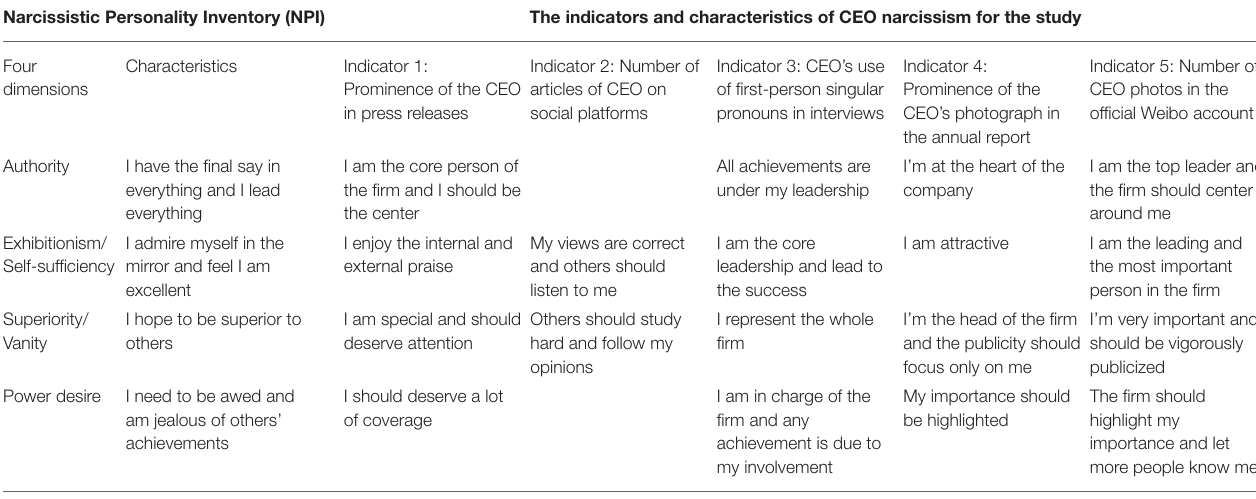
TABLE 2 | Relationship between CEO narcissism indicators and four dimensions of NPI. Narcissistic Personality Inventory (NPI) The indicators and characteristics of CEO narcissism for the study